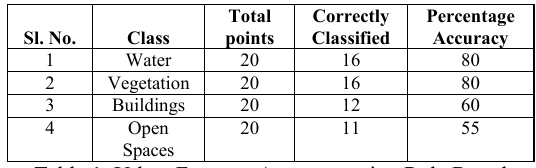
Table 1: Urban Features Accuracy using Rule Based